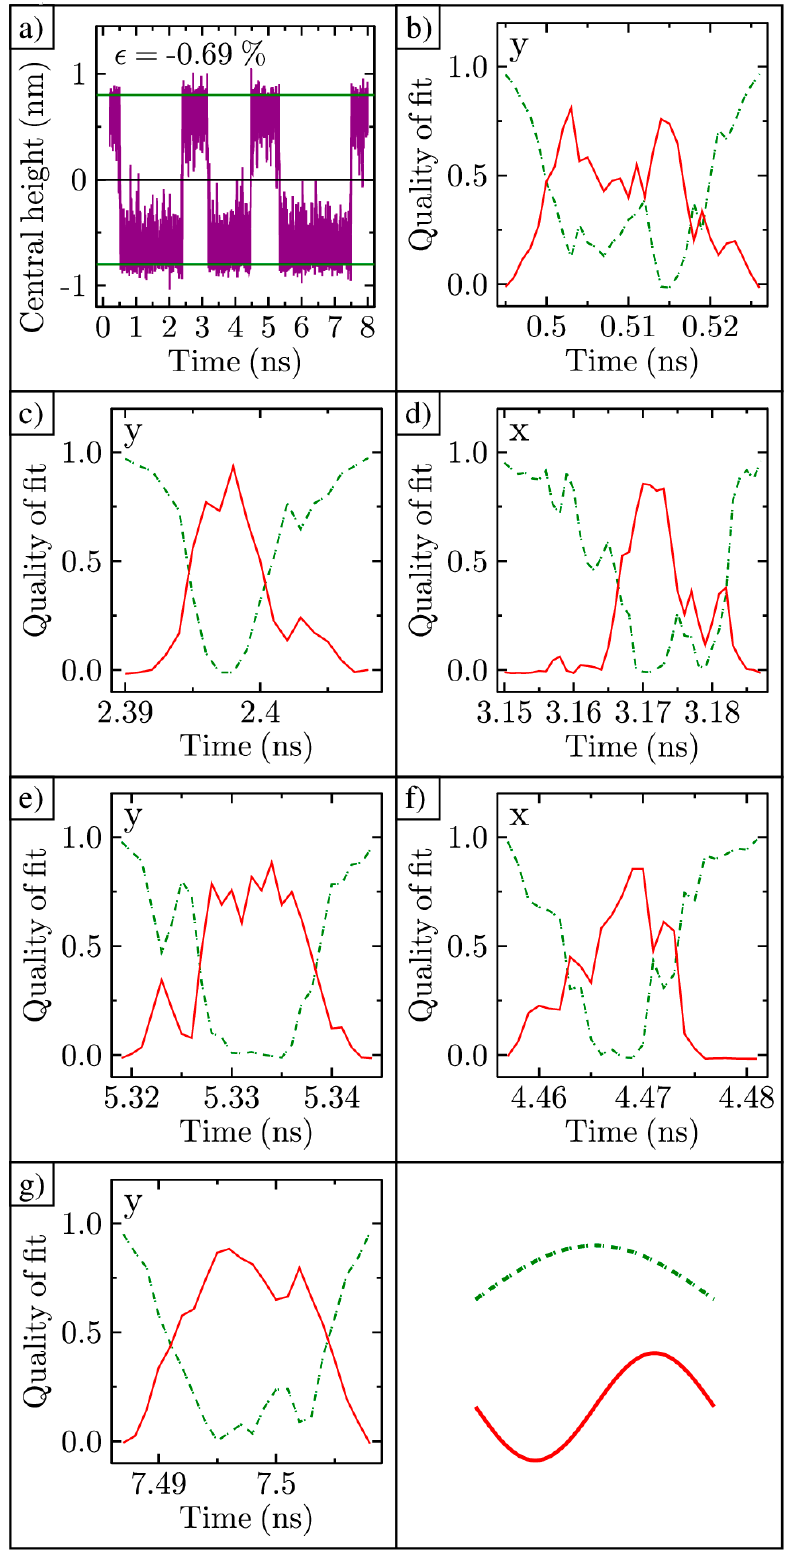
Figure 7. Cosine–sine–cosine shape transformation: ( a ) Central height of ripple in time; ( b – g ) Cosine and sine goodness-of-fit R 2 values for the x - or y -direction (as labeled) cross-section of the ripple in time. Lower right box shows the legend.